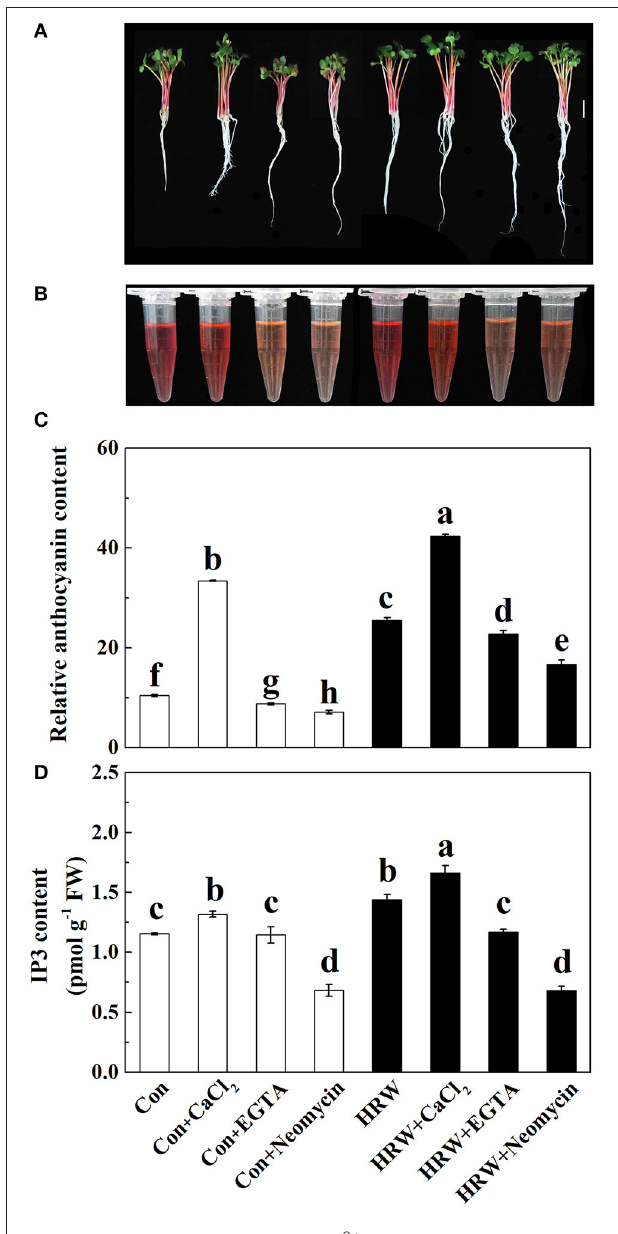
FIGURE 3 | Effects of HRW, CaCl 2 and Ca 2 + antagonists on total anthocyanin content (A–C) and IP3 content (D) of radish sprouts hypocotyls under UV-A irradiation. After cultured in distilled water in the dark for 36h, radish sprouts were incubated in distilled water or HRW (100% saturation) containing 10mM CaCl 2 , 1mM EGTA or 1mM Neomycin under UV-A. The sample with distilled water alone was the control (Con). The hypocotyl color (A) , anthocyanin extraction color (B) and total anthocyanin content (C) were measured at 48h after exposed to UV-A. The IP3 content was measured at 24h after exposed to UV-A (D) . Data are presented as means ± SE ( n = 3). Bars with different letters are significantly different at P < 0.05 according to Duncan’s multiple